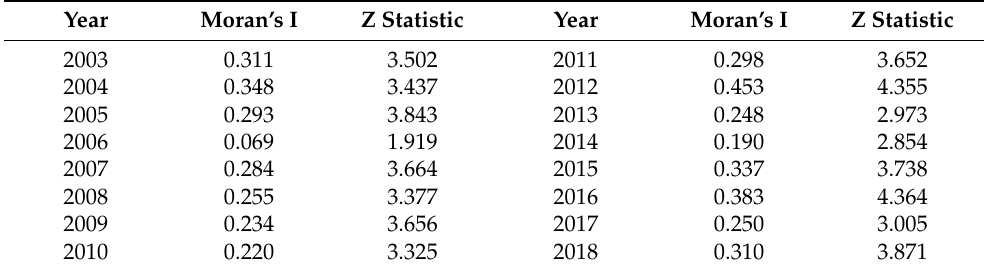
Table 3. Moran’s I and its Z value of the degree of concentration of venture capital in the study